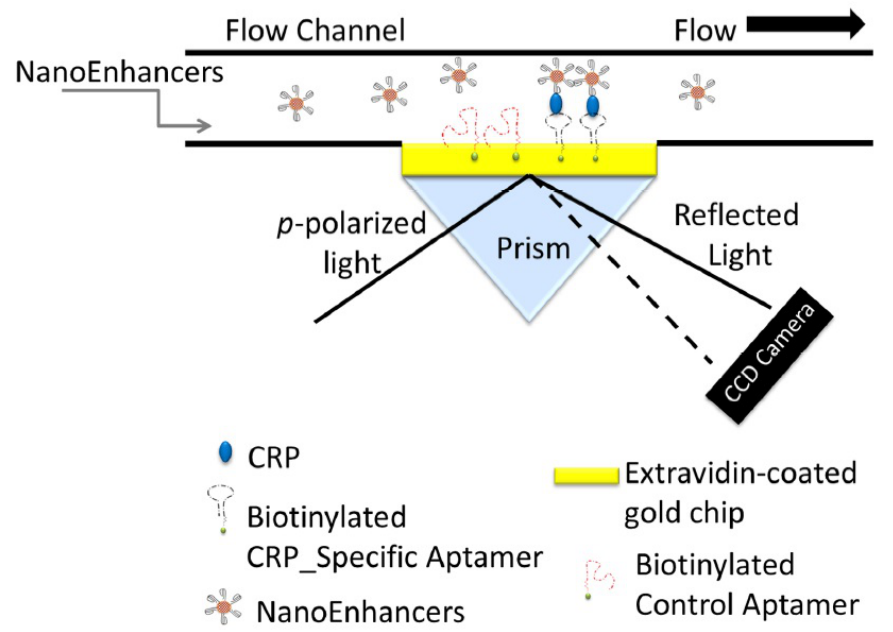
Figure 3. Schematic illustration of a sandwich-based assay using CRP-specific aptamer-coated QDs for SPRi signal amplification (reproduced from reference